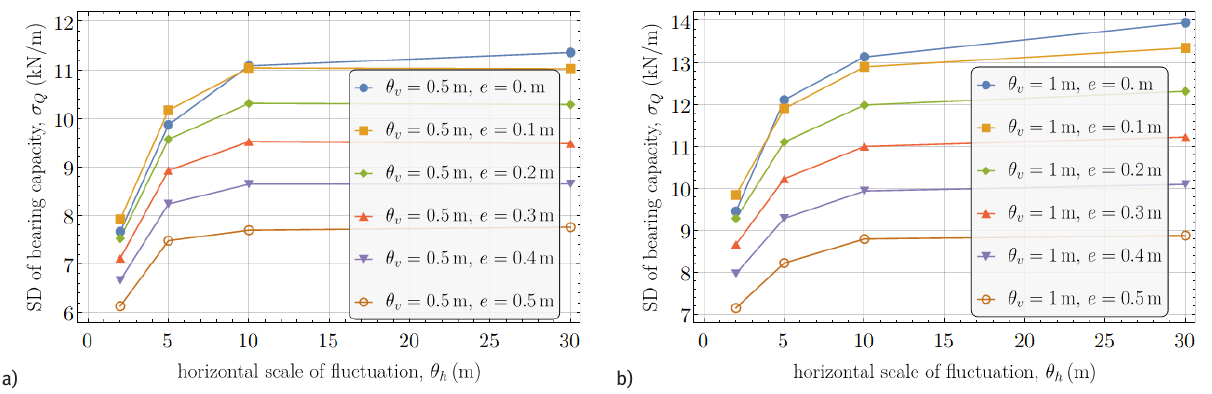
on SD σ for a) θ = 0.5 m and b) θ h Q v